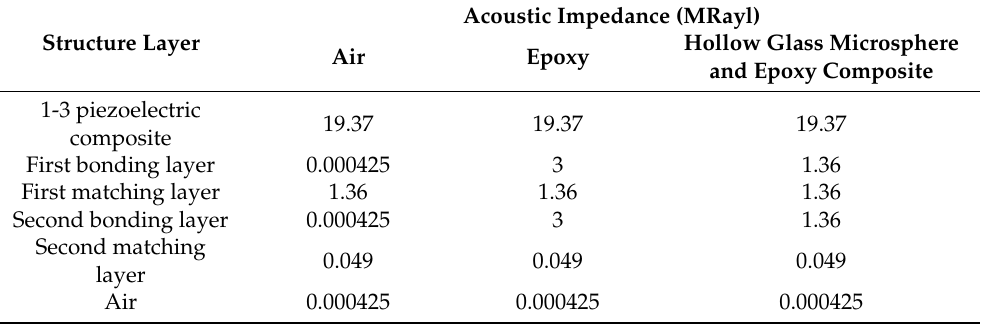
Figure 7. Time–domain filtered and enveloped signal. ( a ) Without bonding layer, ( b ) with the hollow glass beads/epoxy resin system. Table 4. Acoustic impedance distribution of the transducer with three different bonding materials.